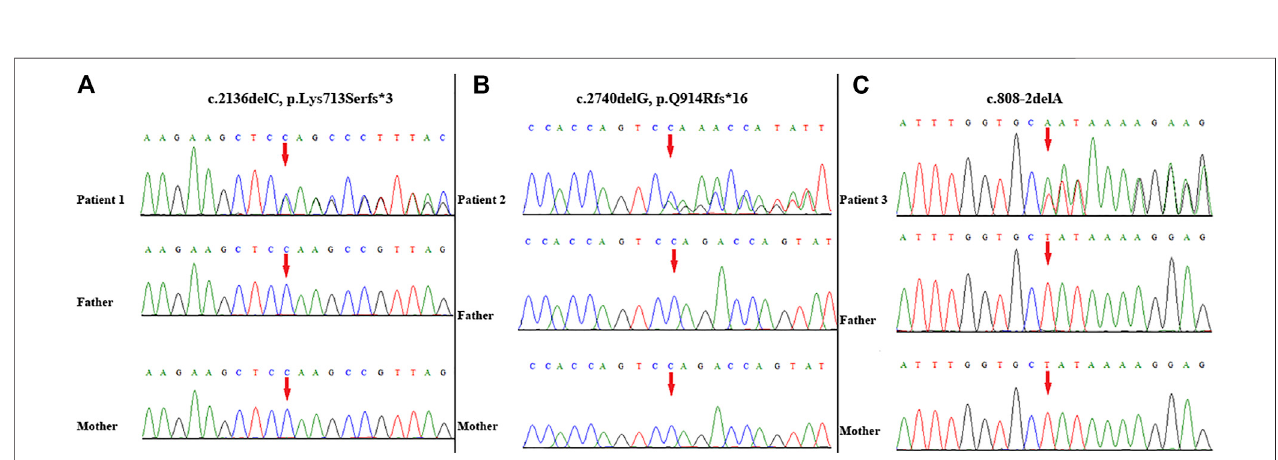
FIGURE 1 | Photographs of patients with Mowat – Wilson syndrome. Note microcephaly, sparse hair and eyebrows, deep-set large and widely spaced eyes, low- setandupturnedearlobes,asaddlenosewitharounded nasaltipandapointed chininpatient1 (A) .Notemicrocephaly,frontalbossing,square-shapedhighforehead, sparse hair and eyebrows, deep-set large and widelyspacedeyes, auricle dysplasia, asaddle nosewitharounded nasal tip, open mouth expression and apointed chin in patient 2 (B) . Note microcephaly, frontal bossing, a square-shaped high forehead, sparse hair, fl aring eyebrows, hypertelorism, auricle dysplasia, low-set and upturned earlobes, a saddle nose with a rounded nasal tip, M-shaped upper lip, open mouth expression and a pointed chin in patient 3 (C) .